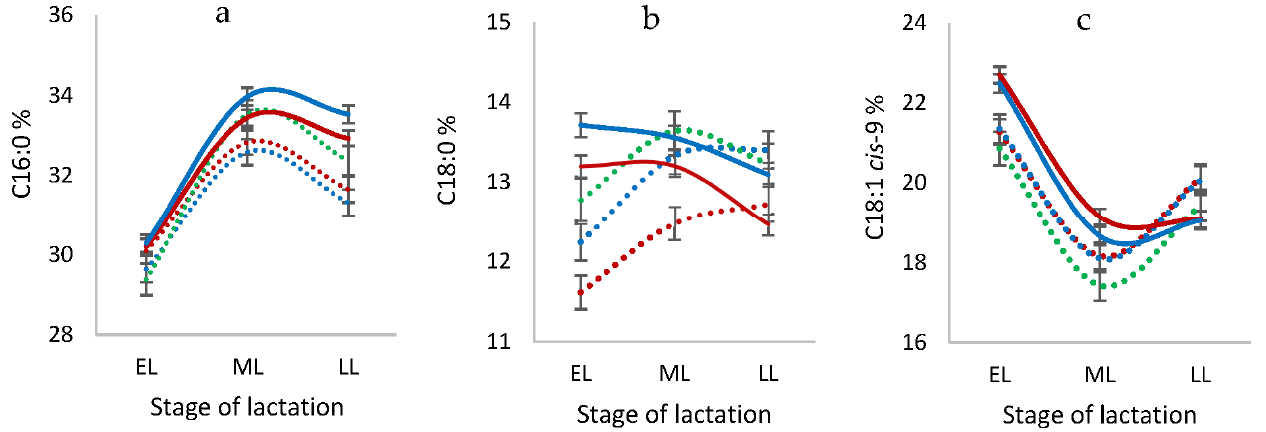
Figure 3. Concentrations of ( a ) C16:0 ( b ) C18:0 ( c ) C18:1 cis -9 in milk from Holstein-Friesian ( …. ), Holstein-Friesian ×Jersey ( …. ) and Jersey ( …. ) cows milked OAD and Holstein-Friesian ( — ) and Holstein-Friesian ×Jersey ( — ) cows milked TAD during the production season 2020–2021. EL = early lactation (<90 days); ML = mid-lactation (90–180 days); LL = late lactation (>180 days). The vertical bars show standard errors.